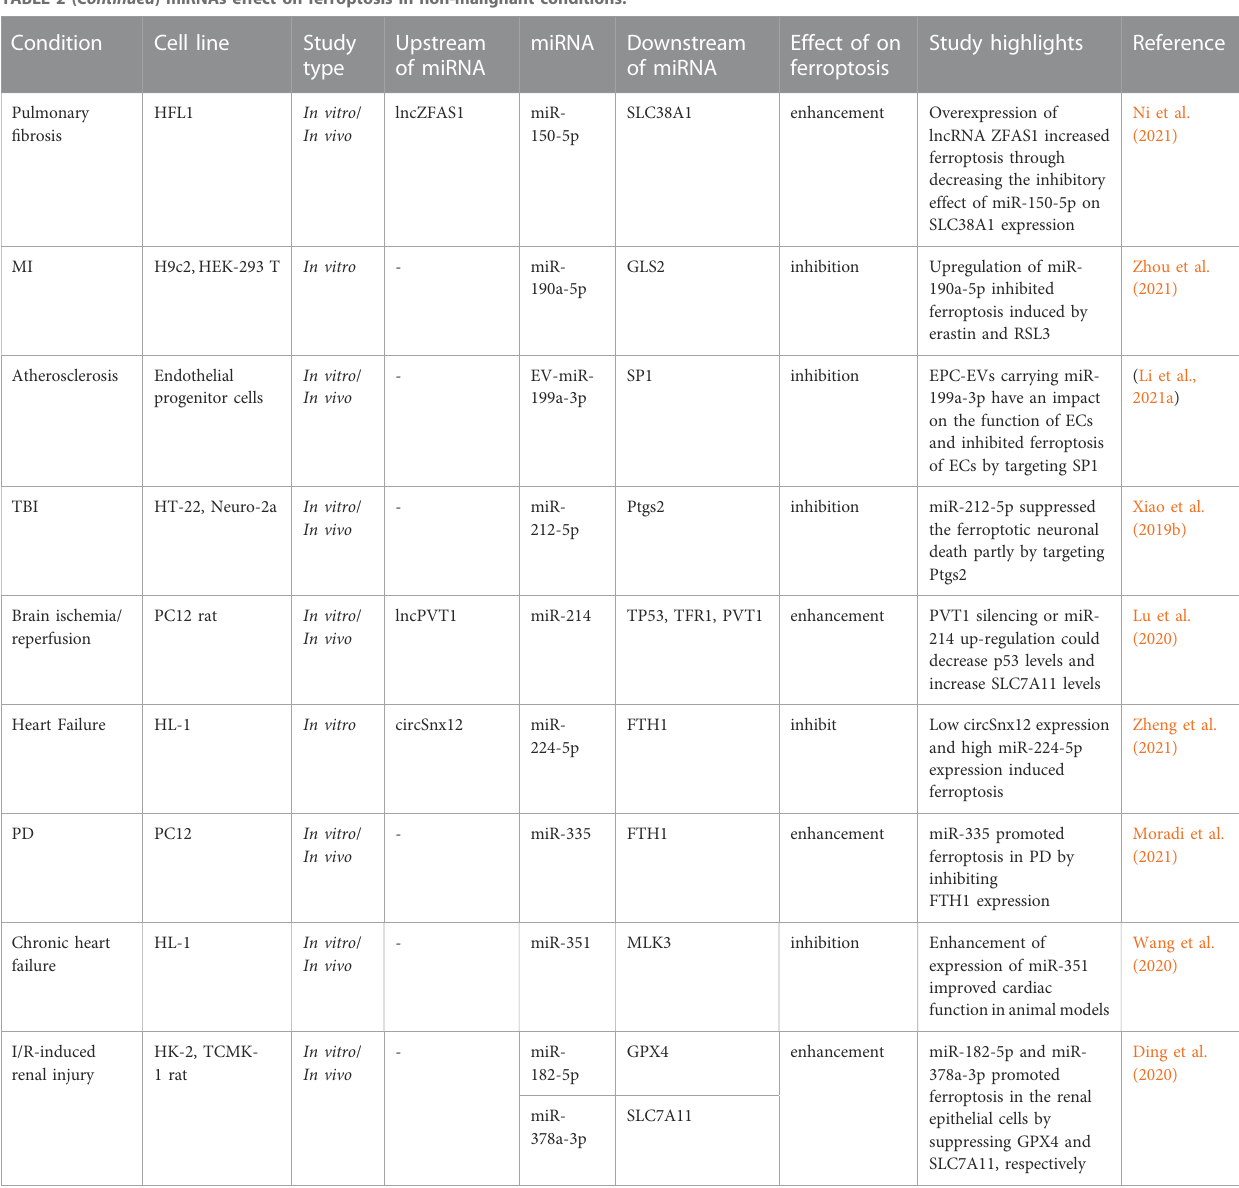
TABLE 2 ( Continued ) miRNAs effect on ferroptosis in non-malignant